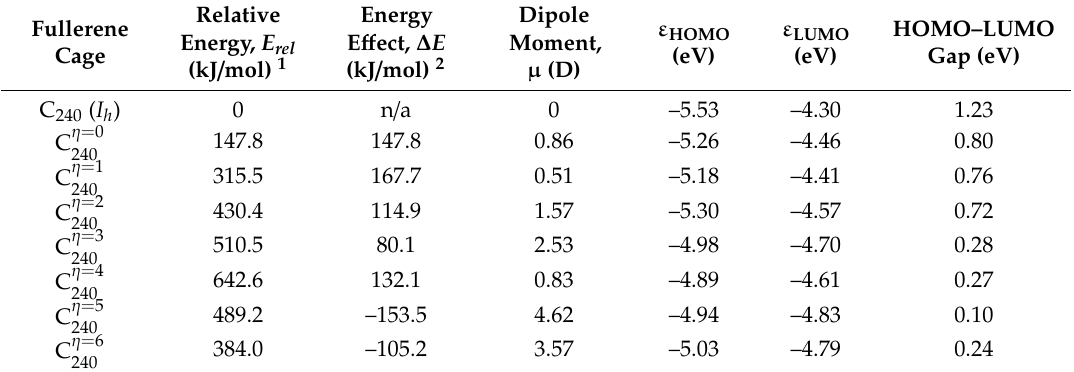
Table 3. Energetic and molecular parameters of original and defected C 240 fullerenes (DFT computations).